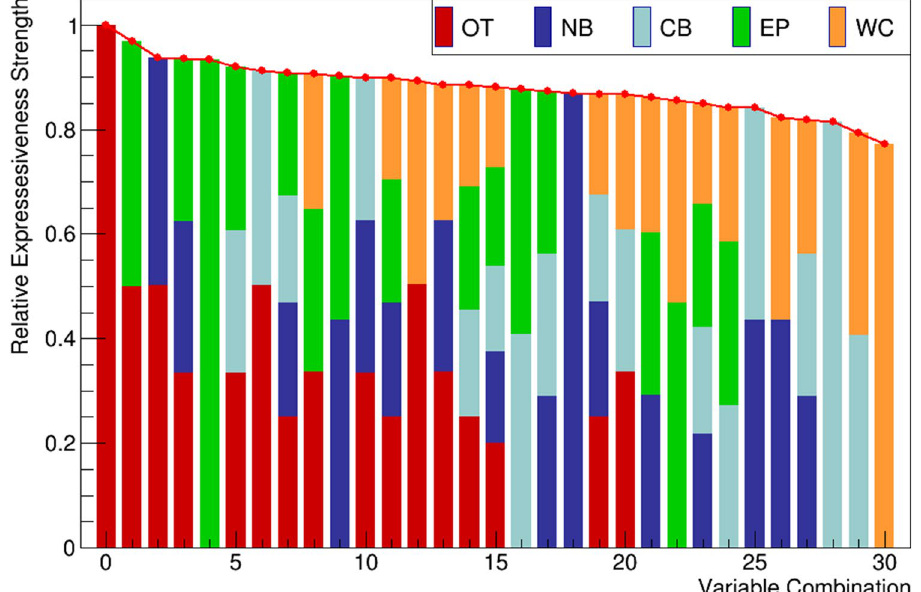
Figure 1. Strength of expressiveness for all combinations of the scoring criteria: (orbital tightening (OT), nose bulge (NB), cheek bulge (CB), ear position (EP), and whisker change (WC)) considering the intervention (injection). The red points indicate the combination importance strength relative to the maximum value, the bars indicate the criterias’ weight within the combination.